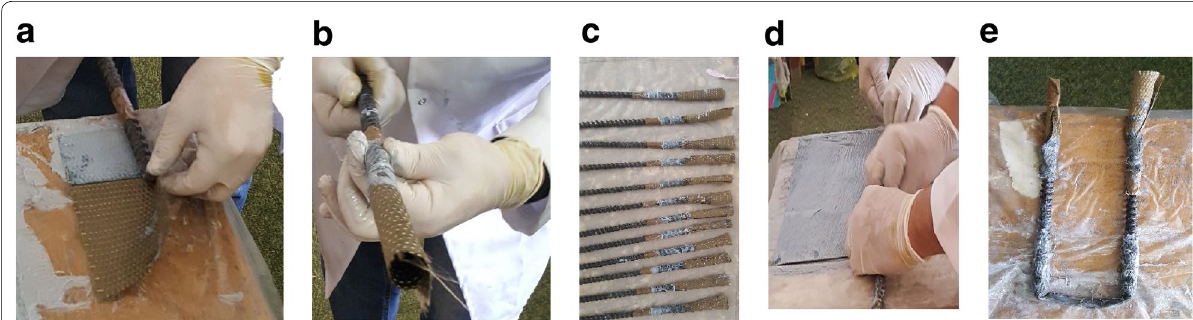
Fig. 5 Fabrication process of the closed BFRP stirrup: a impregnated part of the BFRP sheet during wrapping; b wrapping the BFRP sheet around the bar at the end; c after wrapping the BFRP sheets around the bar ends; d wrapping the impregnated BFRP sheet around the bars at the web; and e final shape of the closed hybrid BFRP stirrup.